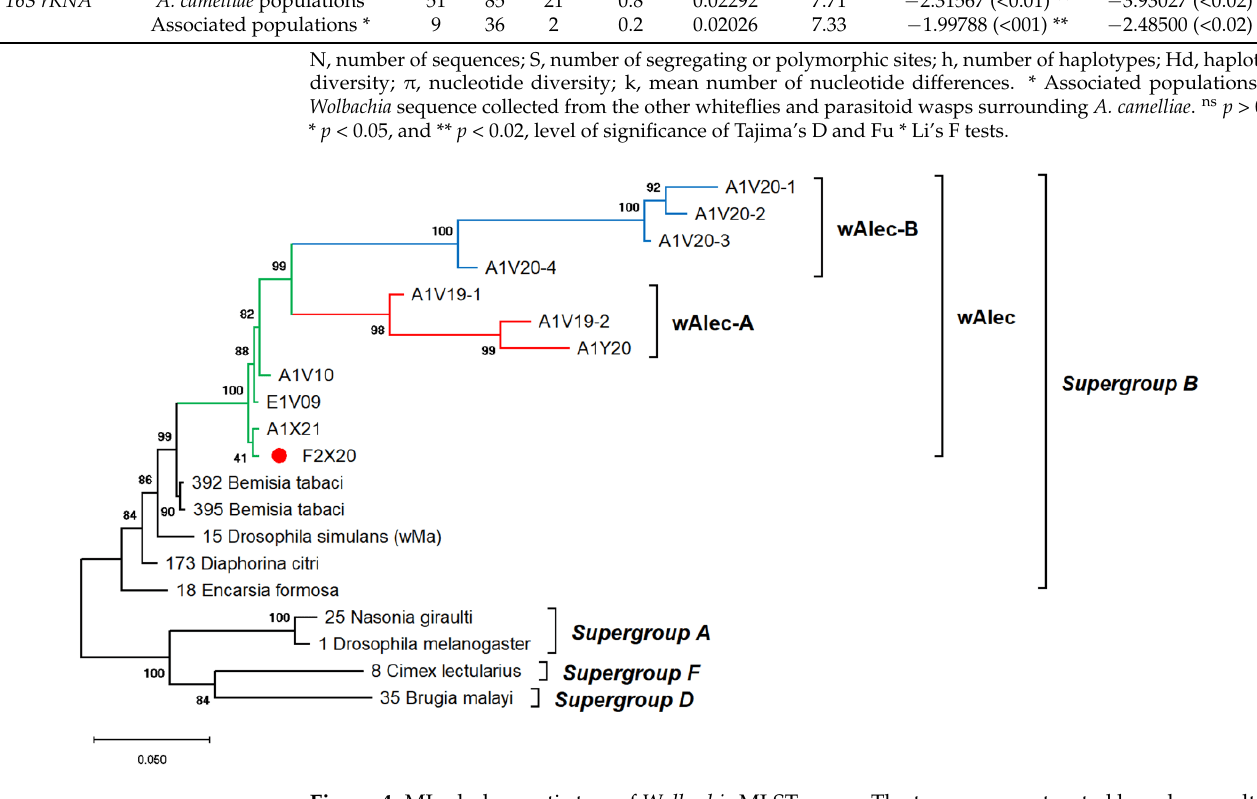
Figure 4. ML phylogenetic tree of Wolbachia MLST genes. The tree was constructed based on multiple alignments of concatenated DNA sequences encoding gatB , coxA , hcpA , ftsZ , and fbpA in ~2 kbp. Bootstrap values are shown for all nodes. A single lineage of wAlec (green line) evolved into two distinct branches of recombinant strains subgroups A (red) and B (blue). The wAlec also infected Aleurocanthus cf. A. spiniferus (red circle).